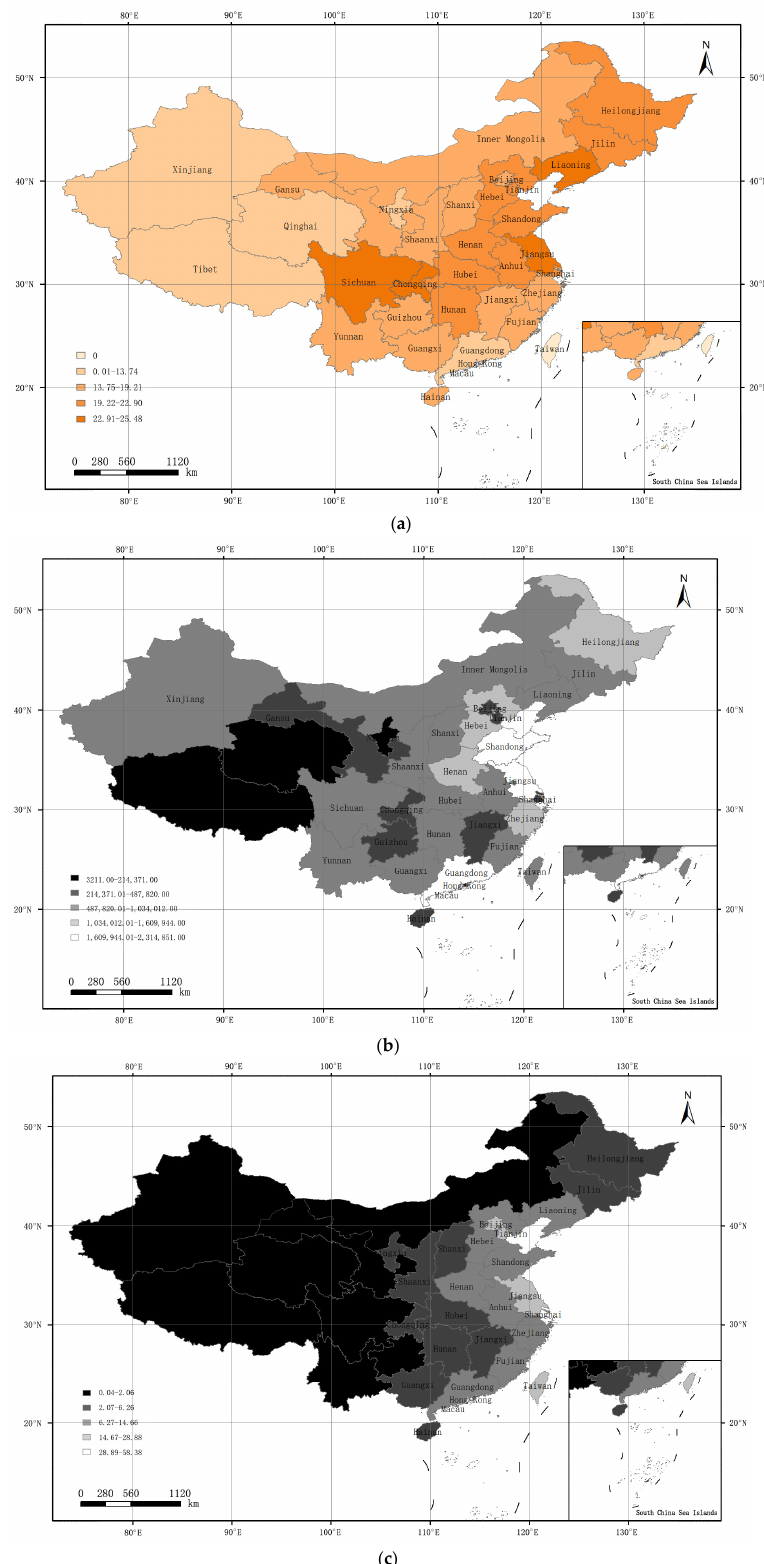
Figure A1. Real provincial ODR, provincial SUM of DN, and provincial MEAN of DN. ( a ) Real provincial ODR; ( b ) Provincial SUM of DN; ( c ) Provincial MEAN of DN. Table A1. Pearson correlations between ODR and nighttime light variables.